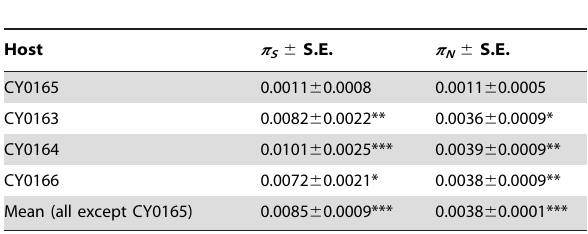
Table 1. Synonymous ( p S ) and nonsynonymous ( p N ) nucleotide diversity in non-overlapping coding regions of SIV